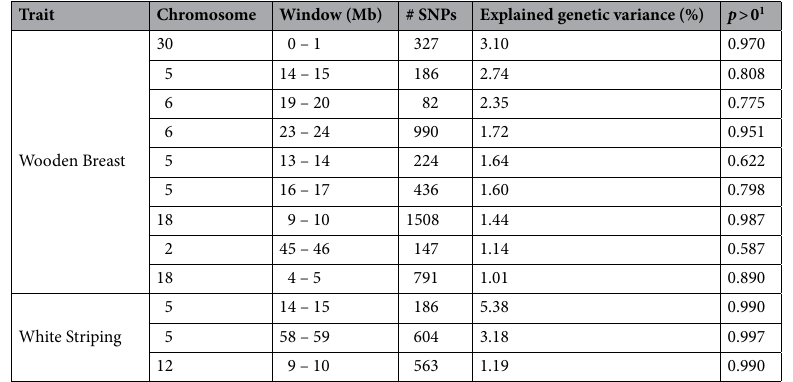
Table 4. Results of Bayesian multi-marker regression for wooden breast and white striping. Windows identified by Bayes B were considered significant if they explained ≥ 1% of genetic variance. Body weight traits did not have any significant 1-Mb windows. P > 0 refers to the frequency of sample for which the region had a nonzero effect.